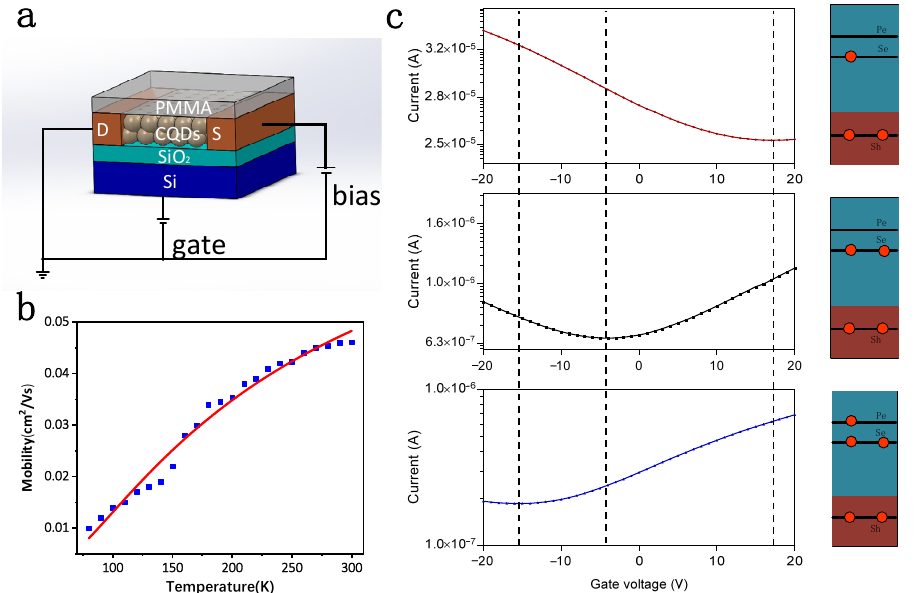
Figure 2. Transport study on HgSe CQDs. ( a ) Schematic diagram of the field effect pipe structure. ( b ) Carrier mobility at different temperatures and mobility fitted with Marcus theory as a function of temperature. ( c ) FET source-drain current as a function of voltage for HgSe/EDT at 80 K.